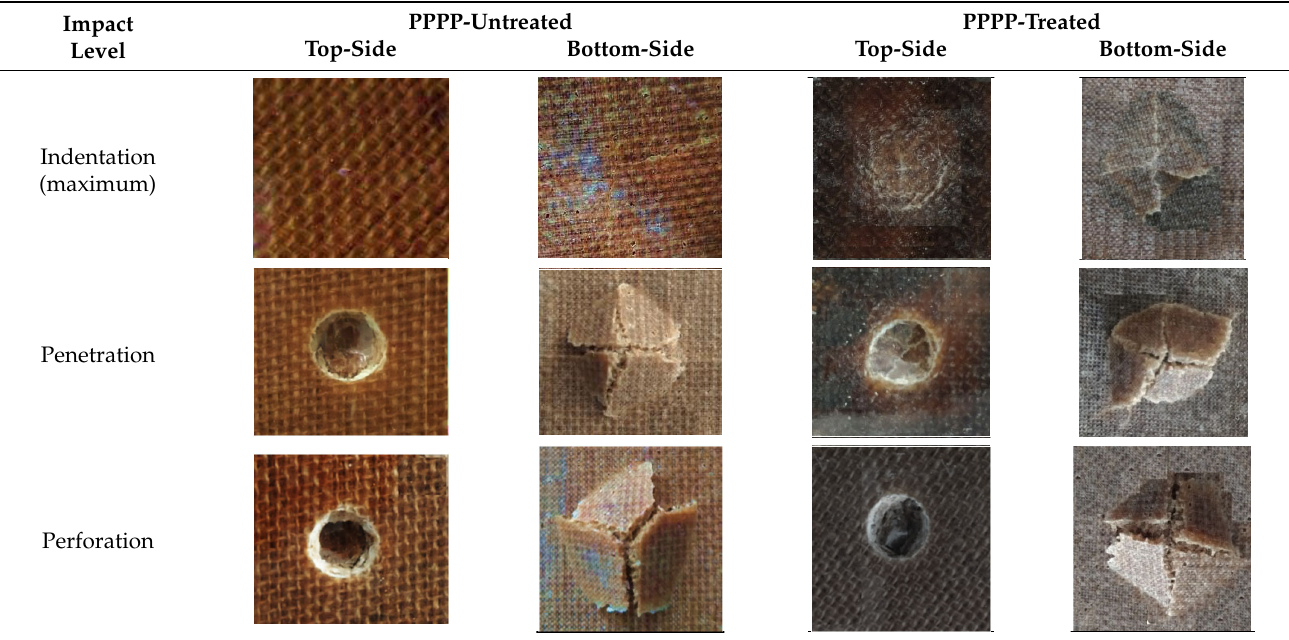
Table 4. Damaged areas of the PPPP-untreated and PPPP-treated laminates at ply orientations of Table 4. Damaged areas of the PPPP ‐ untreated and PPPP ‐ treated laminates at ply orientations of Table 4. Damaged areas of the PPPP ‐ untreated and PPPP ‐ treated laminates at ply orientations of Table 4. Damaged areas of the PPPP ‐ untreated and PPPP ‐ treated laminates at ply orientations of Table 4. Damaged areas of the PPPP ‐ untreated and PPPP ‐ treated laminates at ply orientations of Table 4. Damaged areas of the PPPP ‐ untreated and PPPP ‐ treated laminates at ply orientations of Table 4. Damaged areas of the PPPP ‐ untreated and PPPP ‐ treated laminates at ply orientations of Table 4. Damaged areas of the PPPP ‐ untreated and PPPP ‐ treated laminates at ply orientations of Table 4. Damaged areas of the PPPP ‐ untreated and PPPP ‐ treated laminates at ply orientations of [0 ◦ /90 ◦ ] 8 . Table 4. Damaged areas of the PPPP ‐ untreated and PPPP ‐ treated laminates at ply orientations of Table 4. Damaged areas of the PPPP ‐ untreated and PPPP ‐ treated laminates at ply orientations of Table 4. Damaged areas of the PPPP ‐ untreated and PPPP ‐ treated laminates at ply orientations of Table 4. Damaged areas of the PPPP ‐ untreated and PPPP ‐ treated laminates at ply orientations of [0°/90°] 8 . [0°/90°] 8 . [0°/90°] 8 . [0°/90°] 8 . [0°/90°] 8 . [0°/90°] 8 . [0°/90°] 8 . [0°/90°] 8 . [0°/90°] 8 [0°/90°] 8 . [0°/90°] 8 . [0°/90°] 8 .